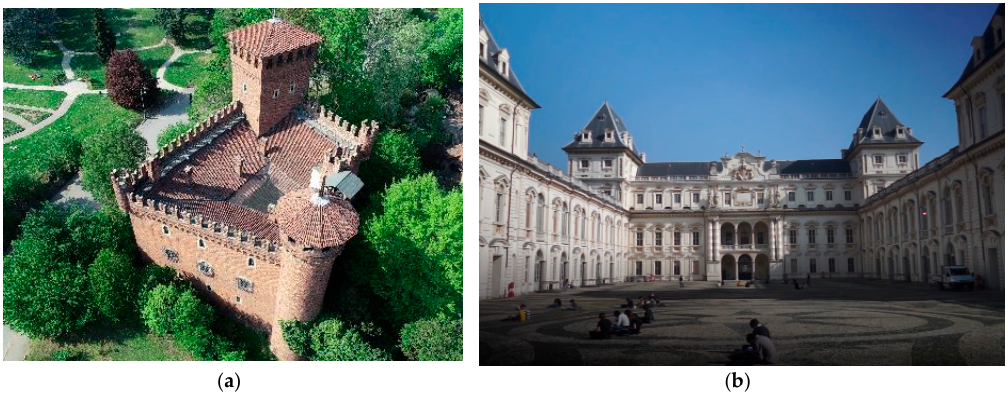
Figure 1. Test area: ( a ) The Rocca in the ‘ Borgo Medievale’ and ( b ) The Valentino Castle.